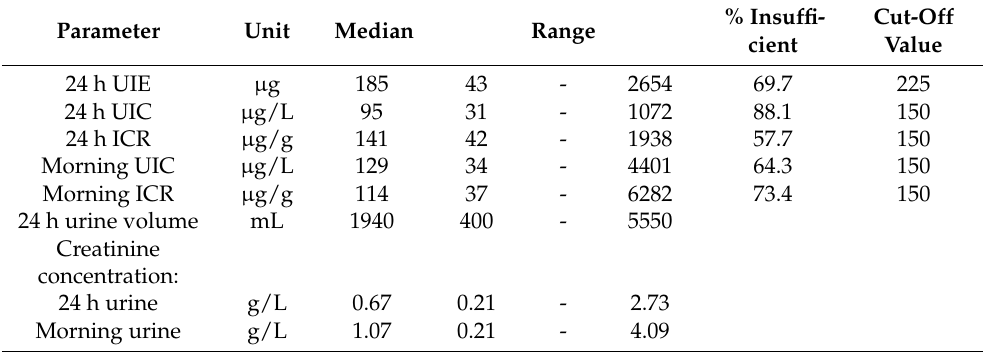
Table 2. Iodine status parameters and urine creatinine concentrations of the pregnant JOZO participants. Parameter Unit